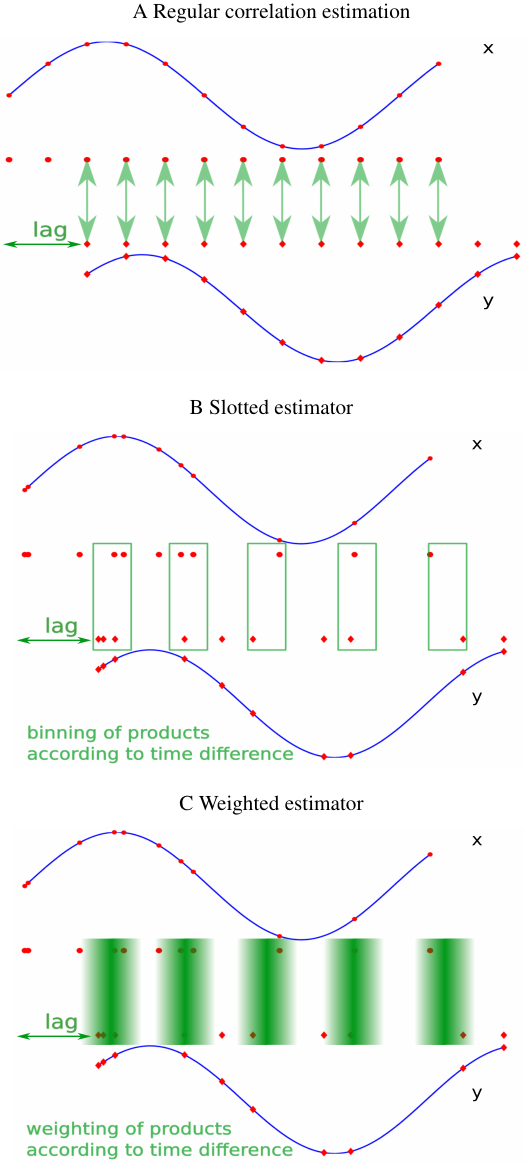
Fig. 1. Principles of correlation function estimation: (A) shows the Fig. 1: Principles of correlation function estimation: (A) classical estimator, where the correlation ˆ ρ xy (k) is given by a mean shows the classical estimator, where the correlation ˆ ρ xy ( k ) is over products of zero-mean observations a lag k apart. (B) For irreg- given by a mean over products of zero-mean observations a ularly sampled time series, the slotted estimator computes ˆ ρ xy (k) as lag k apart. (B) For irregularly sampled time series, the slot- the mean over all products in bins whose centers are a lag k apart. ted estimator computes ˆ ρ xy ( k ) as the mean over all products (C) Non-rectangular correlation uses the weighted mean over all in bins whose centers are a lag k apart. (C) Non-rectangular available products with the weight maxima a lag k correlation uses the weighted mean over all available prod- ucts with the weight maxima a lag k apart.